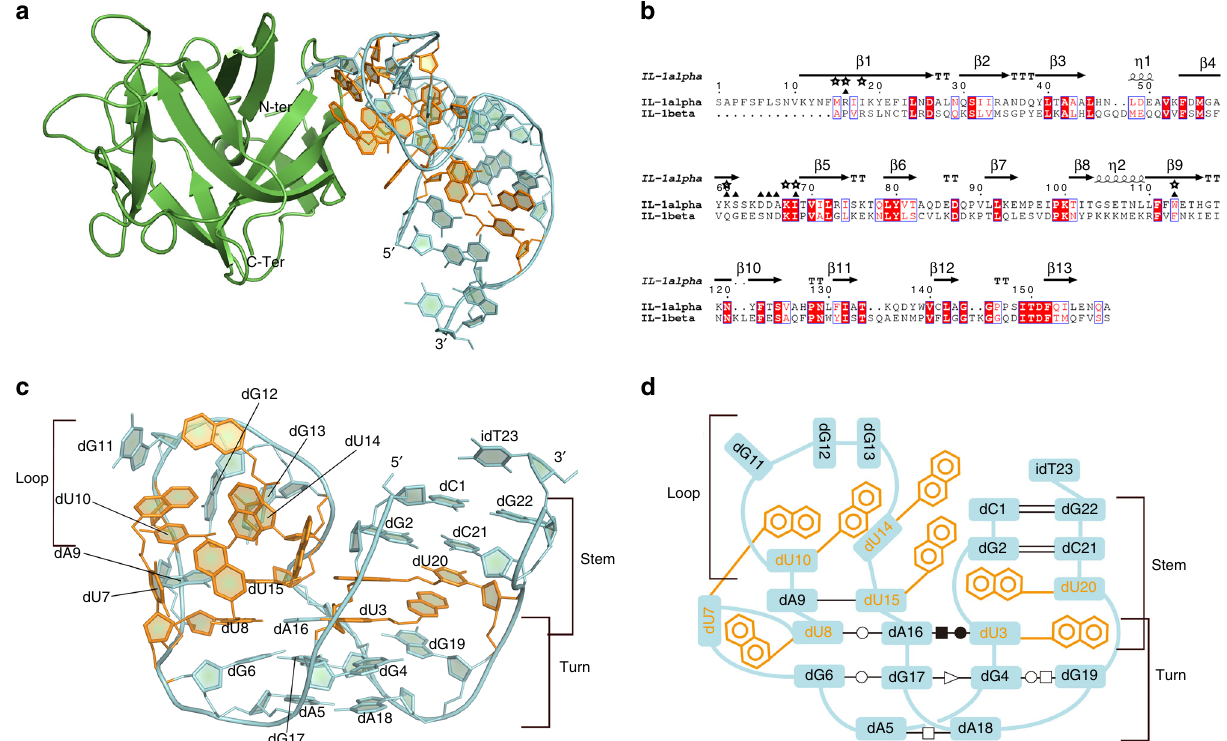
Fig. 1 Structural and schematic representations of the IL-1 α /SL1067 complex and SL1067. a Overall structure of the IL-1 α /SL1067 complex. IL-1 α is colored green and SL1067 is colored cyan with the 2Nap modi fi ed residues colored orange . b Sequence alignment of IL-1 α and IL-1 β . IL-1 α residues that are involved in the non-polar and polar interactions with SL1067 are denoted with black stars and triangles separately. c Side view of the SL1067 structure. The Nap modi fi ed nucleotides are colored orange . d Schematic representation of SL1067. The three parts of SL1067: stem, turn, and loop are marked. All the base pairs are labeled according to the nomenclature of Leontis et al.